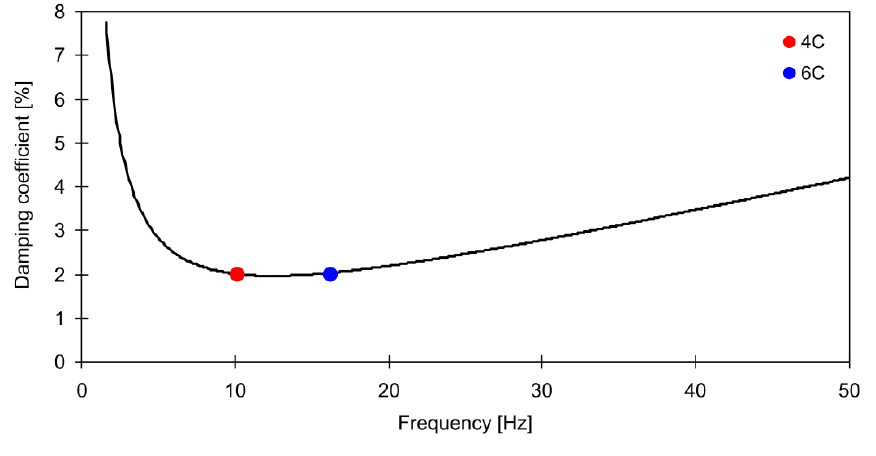
Figure 6. Rayleigh damping curve.